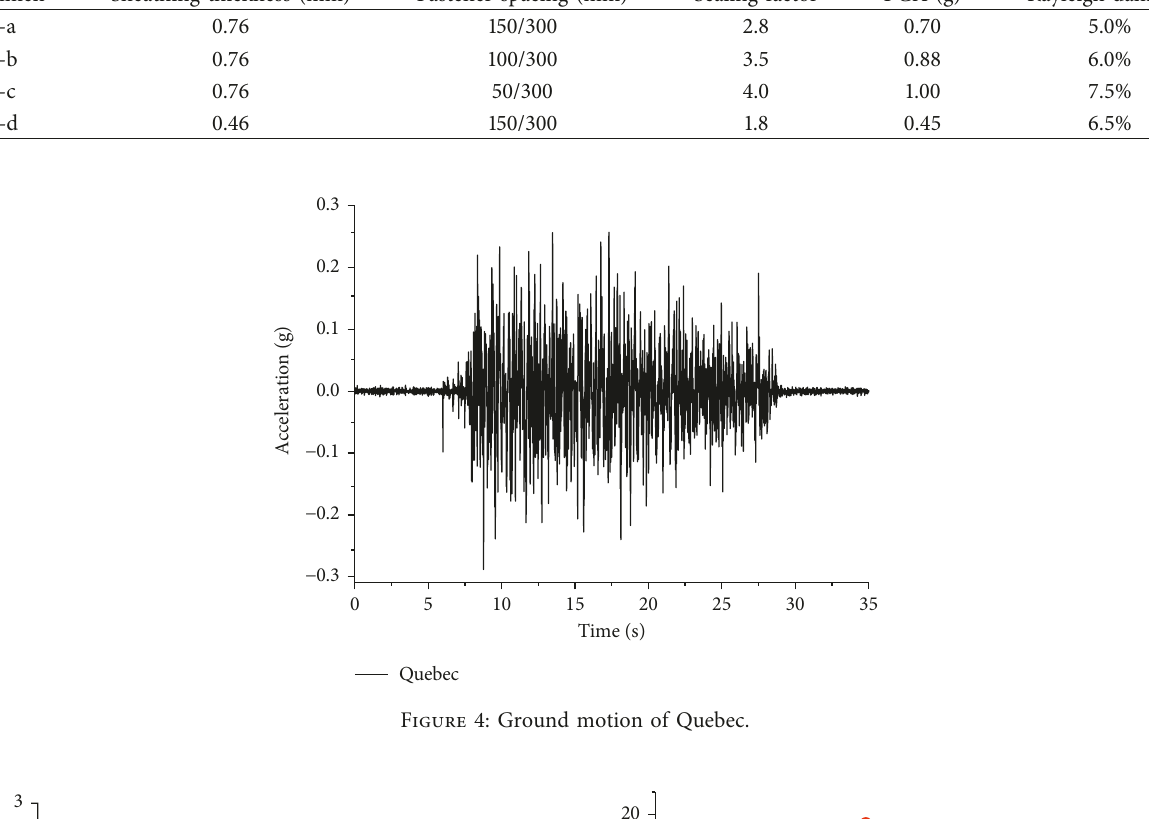
Table 2: Configurations of the tested single-bay single-story steel-sheathed CFSF walls. Specimen